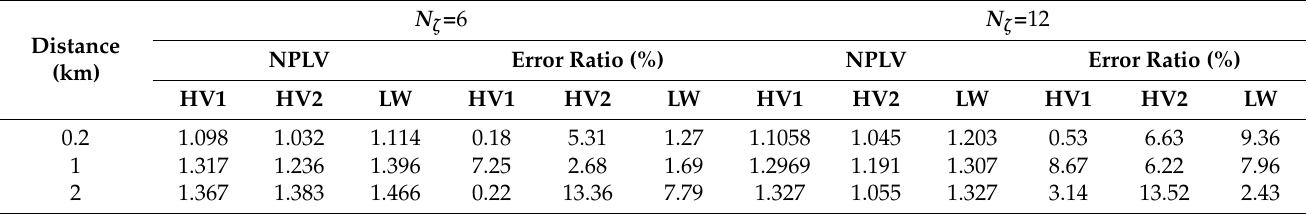
Table 5. Simulated averaged NPLVs for different spectral coherence models and different N ζ